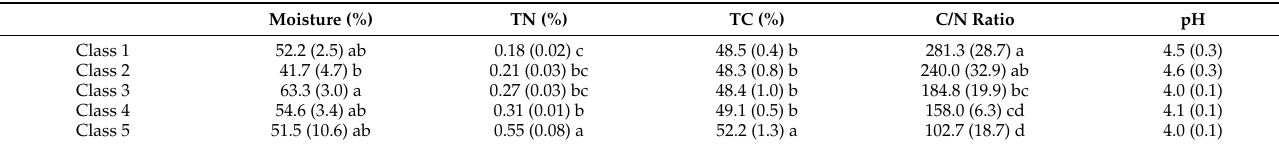
Table 1. Average values of moisture, total C (TC) and total N (TN) contents, C/N ratio, and pH of the black pine deadwood cores from the different decay classes. Moisture, TC, and TN contents were calculated as percentage of the total dry mass of deadwood. Standard errors in parentheses. Different letters in a column indicate significant differences at p < 0.05 (LSD test) among means.